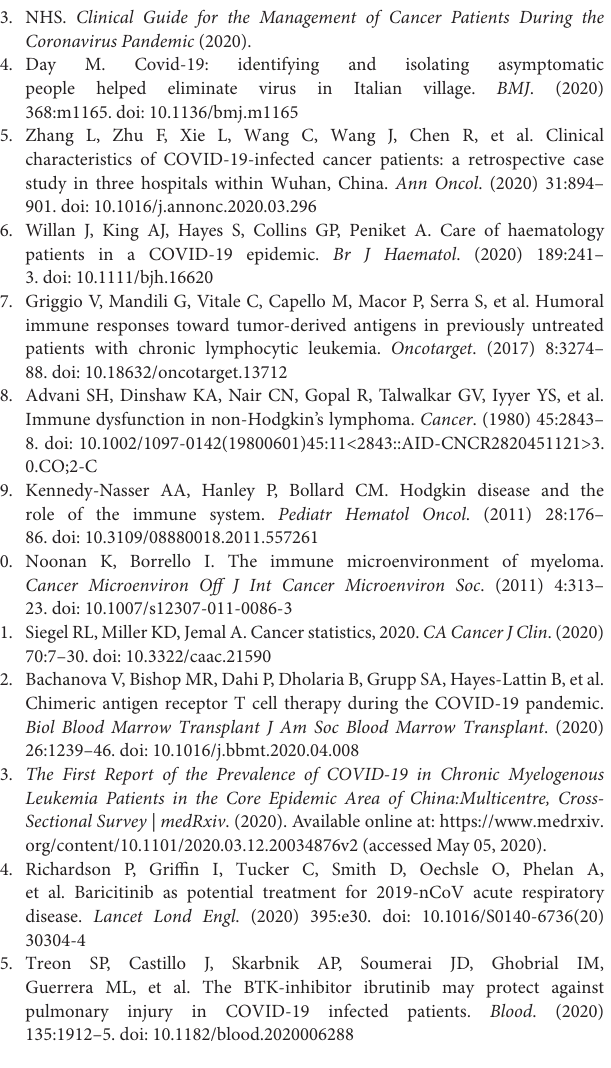
FIGURE 1 | ACVBP. Symptoms were cough and fever. SARS-CoV-2 rt-PCR was positive. On CT-scan, the CT score CORADS was 5. The axial CT image showed ordinary COVID-19 pneumonia with multiple regions of subpleural GGO (Ground Glass opacity) with superimposed inter and intralobular septal thickening. (D) Pneumocystis in a 58-year-old patient followed for acute leukemia. The clinical exam revealed a cough and fever. The patient was lymphopenic. CT-scan showed diffused ground-glass opacities. SARS-CoV-2 rt-PCR was negative. The final diagnosis was pneumocystis. (E) Diffuse pulmonary condensation in a